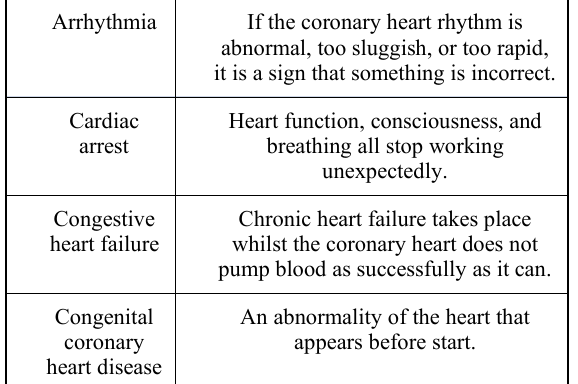
Table 1 . Different types of heart disease